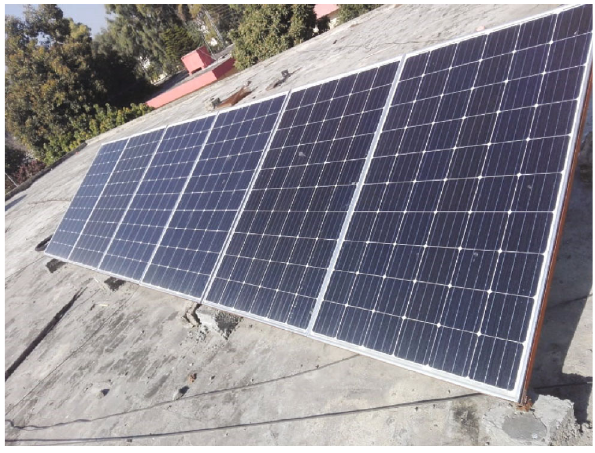
Figure 3: Solar panels